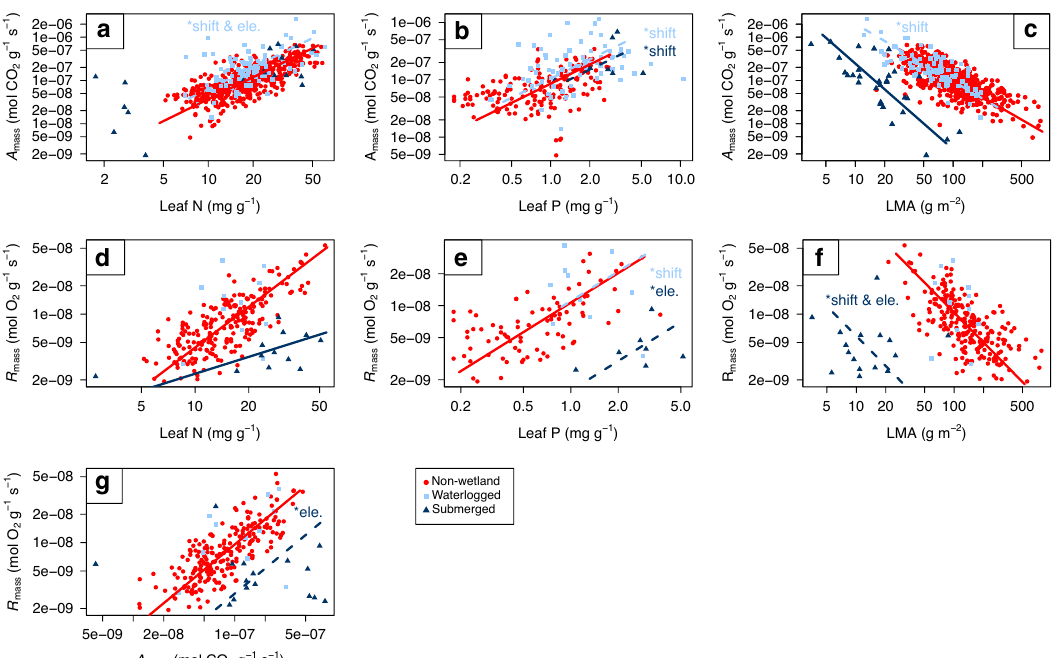
Fig. 2 The bivariate associations with photosynthetic rate and dark respiration rate. a Photosynthetic rate ( A mass ) vs. leaf nitrogen (leaf N). b A mass vs. leaf phosphorus (leaf P). c A mass vs. leaf dry mass per unit area (LMA). d Dark respiration rate ( R mass ) vs. leaf N. e R mass vs. leaf P. f R mass vs. LMA. g A mass vs. R mass . The waterlogged and submerged wetland plants are shown in light blue squares and dark blue triangles, respectively. The non-wetland plant data from GLOPNET 3 are shown in red circles with a solid red line. If the slope for wetland plants differs signi fi cantly from that of non-wetland plants, this is indicated by a solid dark or light blue line, for waterlogged and submerged plants, respectively. Dashed lines with the notation of *shift and/or *ele . identify a signi fi cant shift along the common slope, and/or signi fi cant elevation differences among parallel slopes, respectively. Note that graph axes are log 10 scaled.